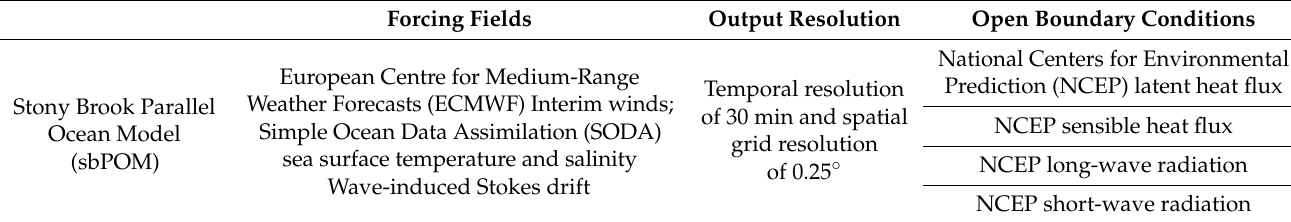
Figure 5. ( a ) The monthly average sea surface temperature; and ( b ) average sea surface salinity from Simple Ocean Data Assimilation (SODA) data in July 2015. Table 1. The basic settings for the Stony Brook Parallel Ocean Model (sbPOM).